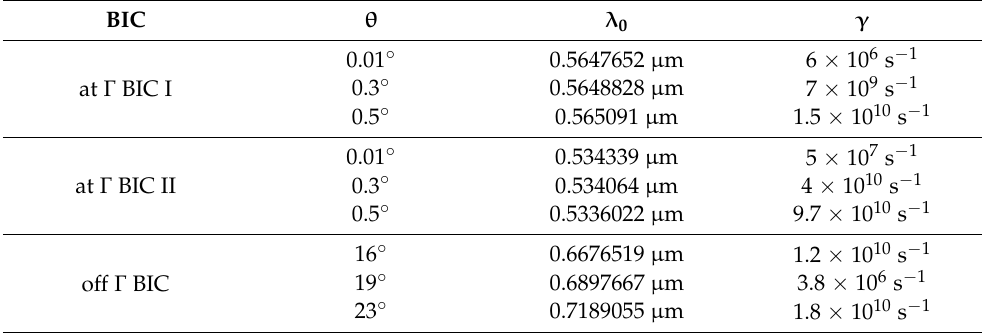
Table 1. Center wavelength λ 0 and damping rate γ for CMT results at different incident angles θ in Figures 3 and 4.